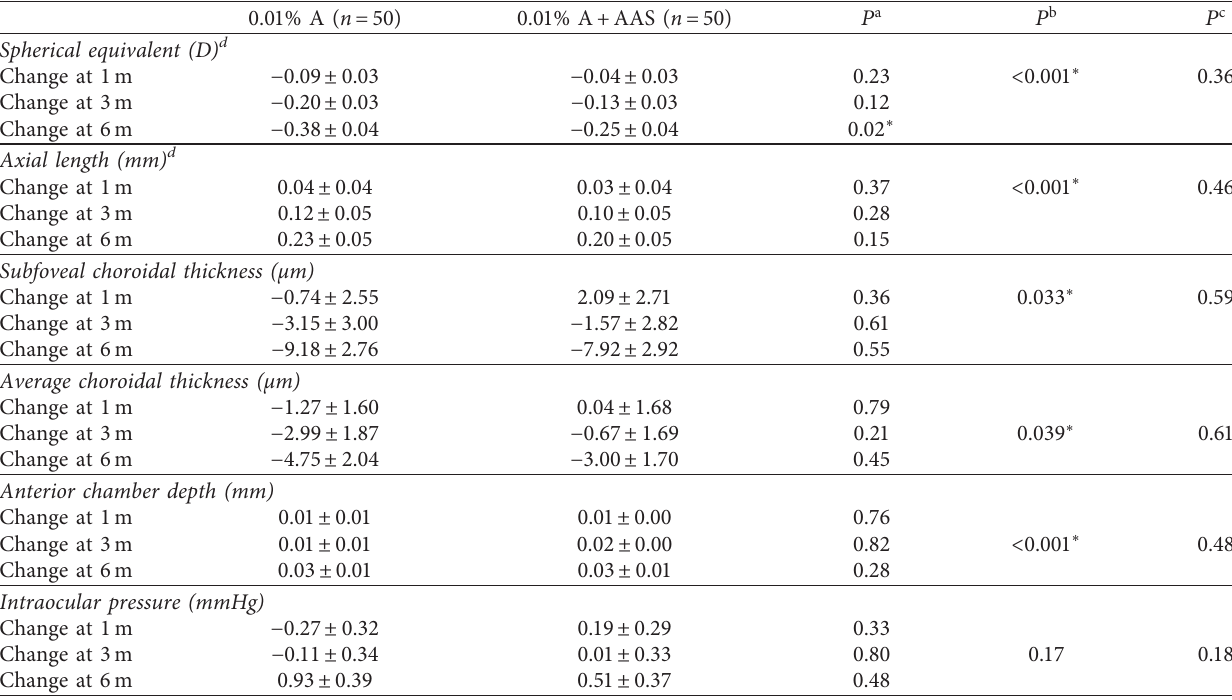
Table 2: Change in ocular parameters at different